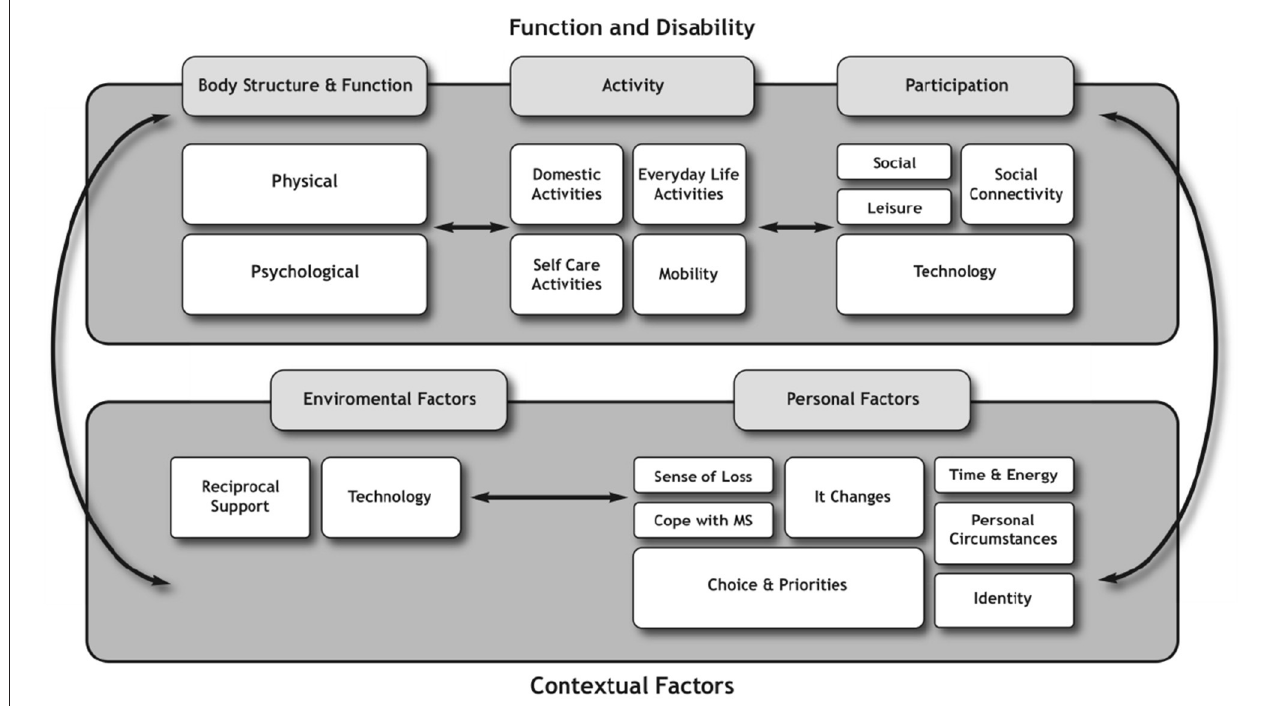
FIGURE 2 | Representation of the experiential (people with MS) perspective in relation to the ICF.